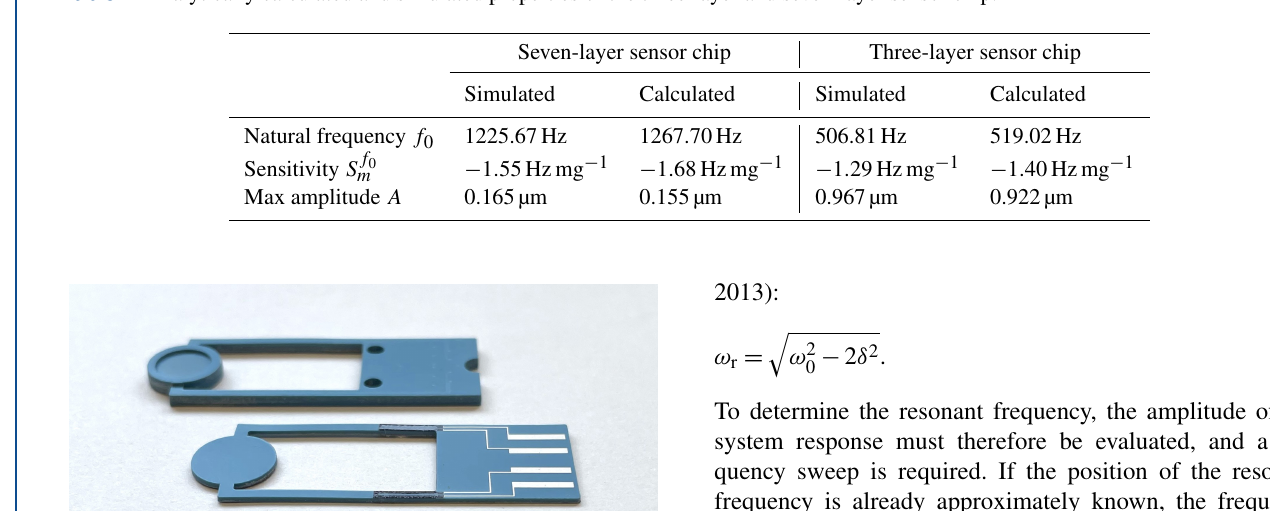
Table 1. Analytically calculated and simulated properties of the three-layer and seven-layer sensor chip.